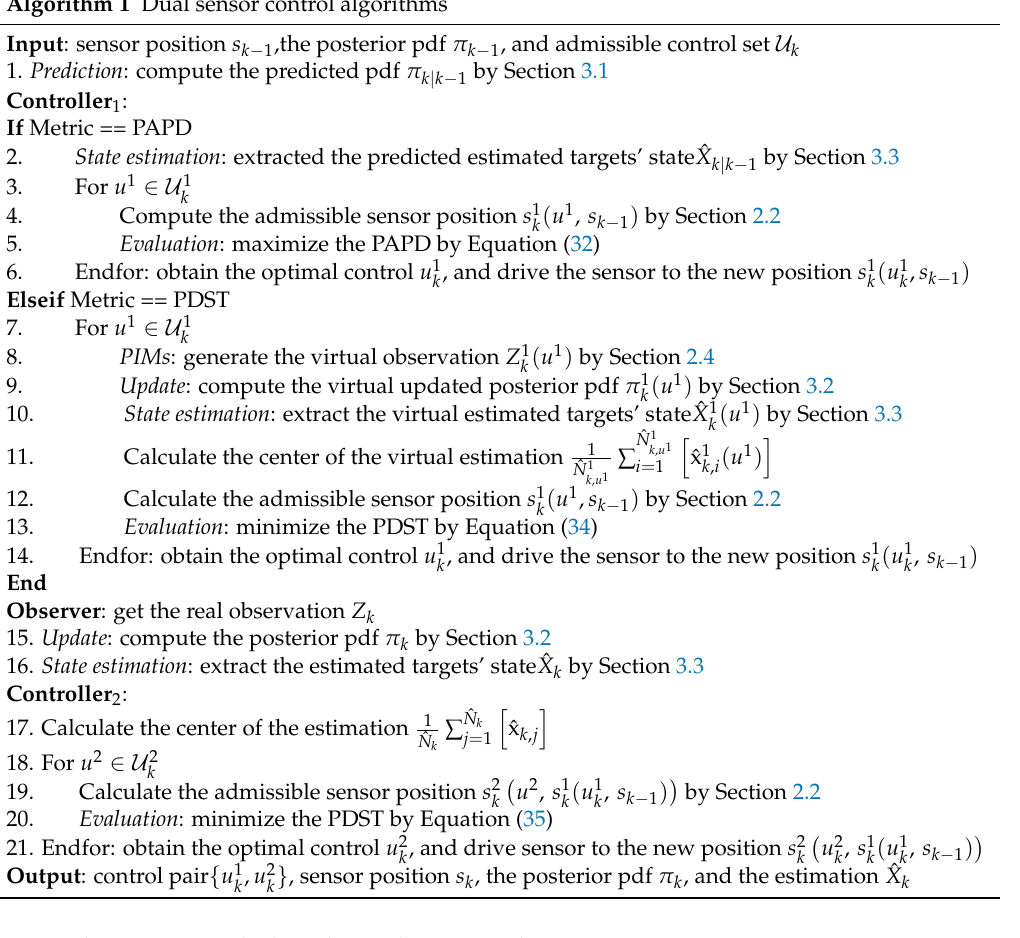
Algorithm 1 Dual sensor control